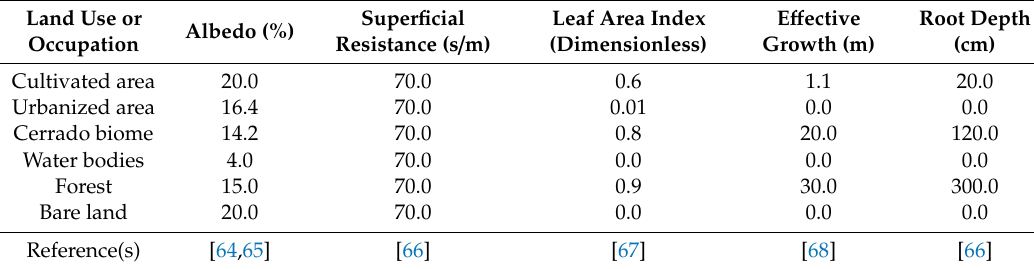
Table 2. Land use and occupation parameters used in the hydrologic model.